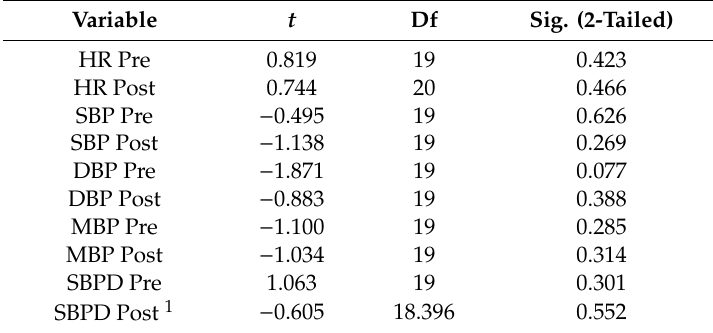
Table 1. Independent t -test for sex di ff erences in the blood pressure